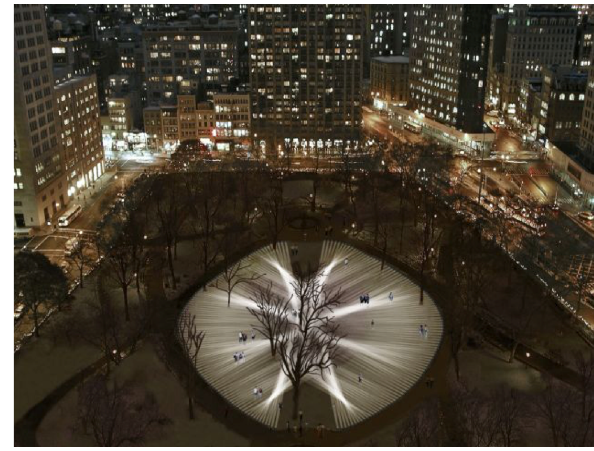
Figure 5 | Rafael Lozano-Hemmer, Pulse Park , Relational Architecture 14, 2008. Sketch by Antimodular Research.